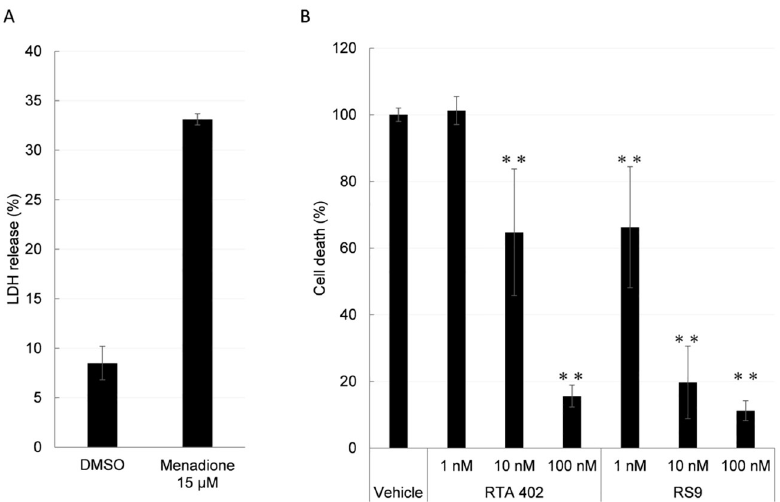
Fig 2. LDH cytotoxicity assay after menadione treatment. A, Cell death was induced by 15 μ M of menadione. LDH release was measured 30 hours after menadione treatment. B, HCE-T cells were pre-treated with compounds for 24 hours, and then were further incubated for 30 hours with compounds in the presence of 15 μ M menadione. LDH release was assessed after incubation. The percentage of cell death was calculated based on LDH release from normal and menadione-treated HCE-T cells. RTA 402 and RS9 pretreatment reduced cell damage in a concentration- dependent manner. RS9 protected against cell death at a lower concentration compared with RTA 402. Experiments were conducted in triplicate and repeated twice. Representative data are shown. Data are expressed as the means ± SD. �� P < 0.01 compared with vehicle under menadione treatment, Dunnett’s test.